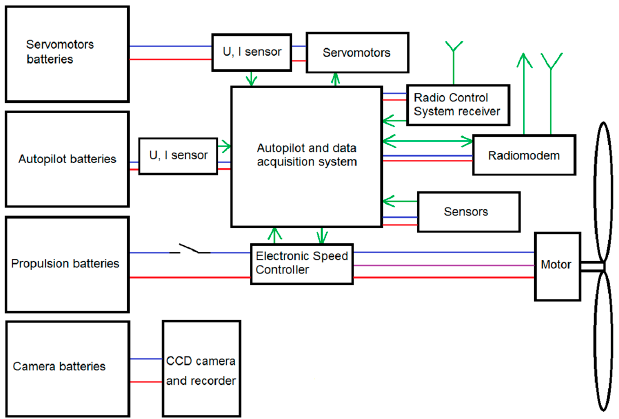
Figure 5. Electric/electronic system architecture of the demonstrator. CCD: charge-coupled device.